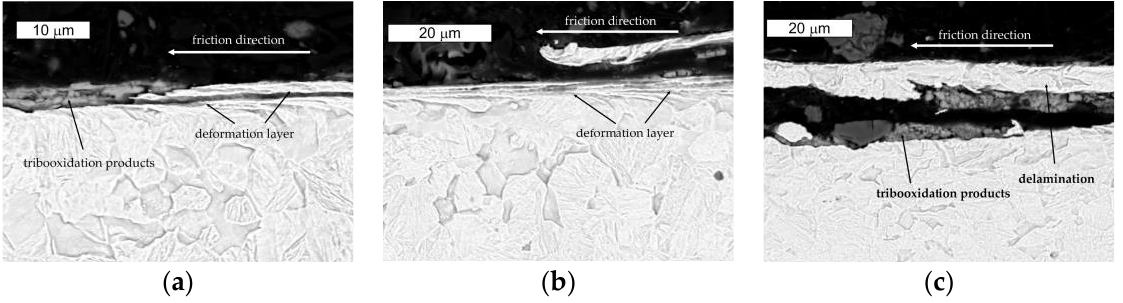
Figure 17. Microstructure of steel Hardox in the surface area observed in different zones. Transverse direction to the friction direction. SEM, etched.